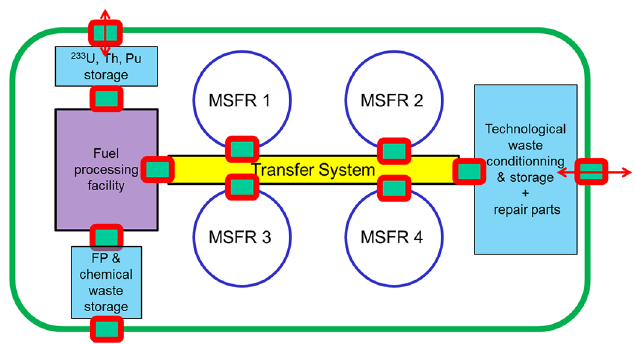
Fig. 1. Schematic representation of a nuclear site with 4 reactors sharing common facilities. Green rectangles with red contours represent monitoring chambers for any transfer in or out the elements. Internal transfers on site are made by remote handling Table 1. Isotope inventories (in kilograms, unless otherwise stated). Isotope